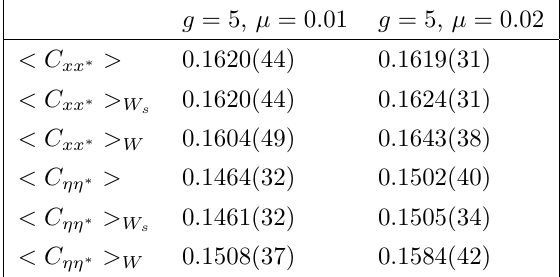
Table 2 . E(cid:11)ect of the reweighting on the two-point functions.